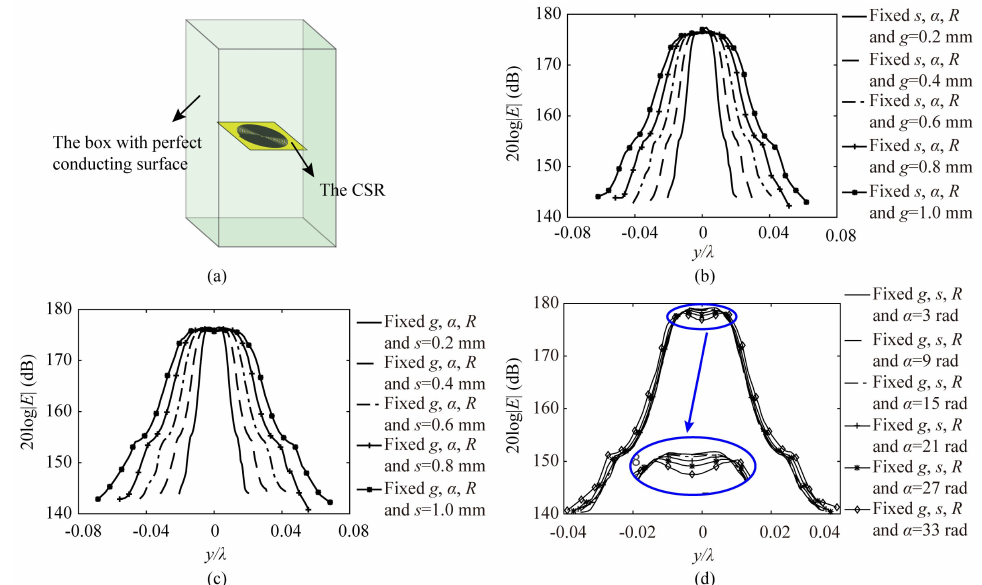
Figure 2. ( a ) The sketch of CSR set into the box of perfect conducting surfaces for eigenmode analysis; ( b ) The electric fields distributions along the red dashed line 1 mm above the CSRs varying with the width of spiral slots g ; ( c ) The electric fields distributions along the red dashed line 1 mm above the CSRs varying with the width of the spiral metal strip s ; ( d ) The electric fields distributions along the red dashed line 1 mm above the CSRs varying with the start angle of the spiral α